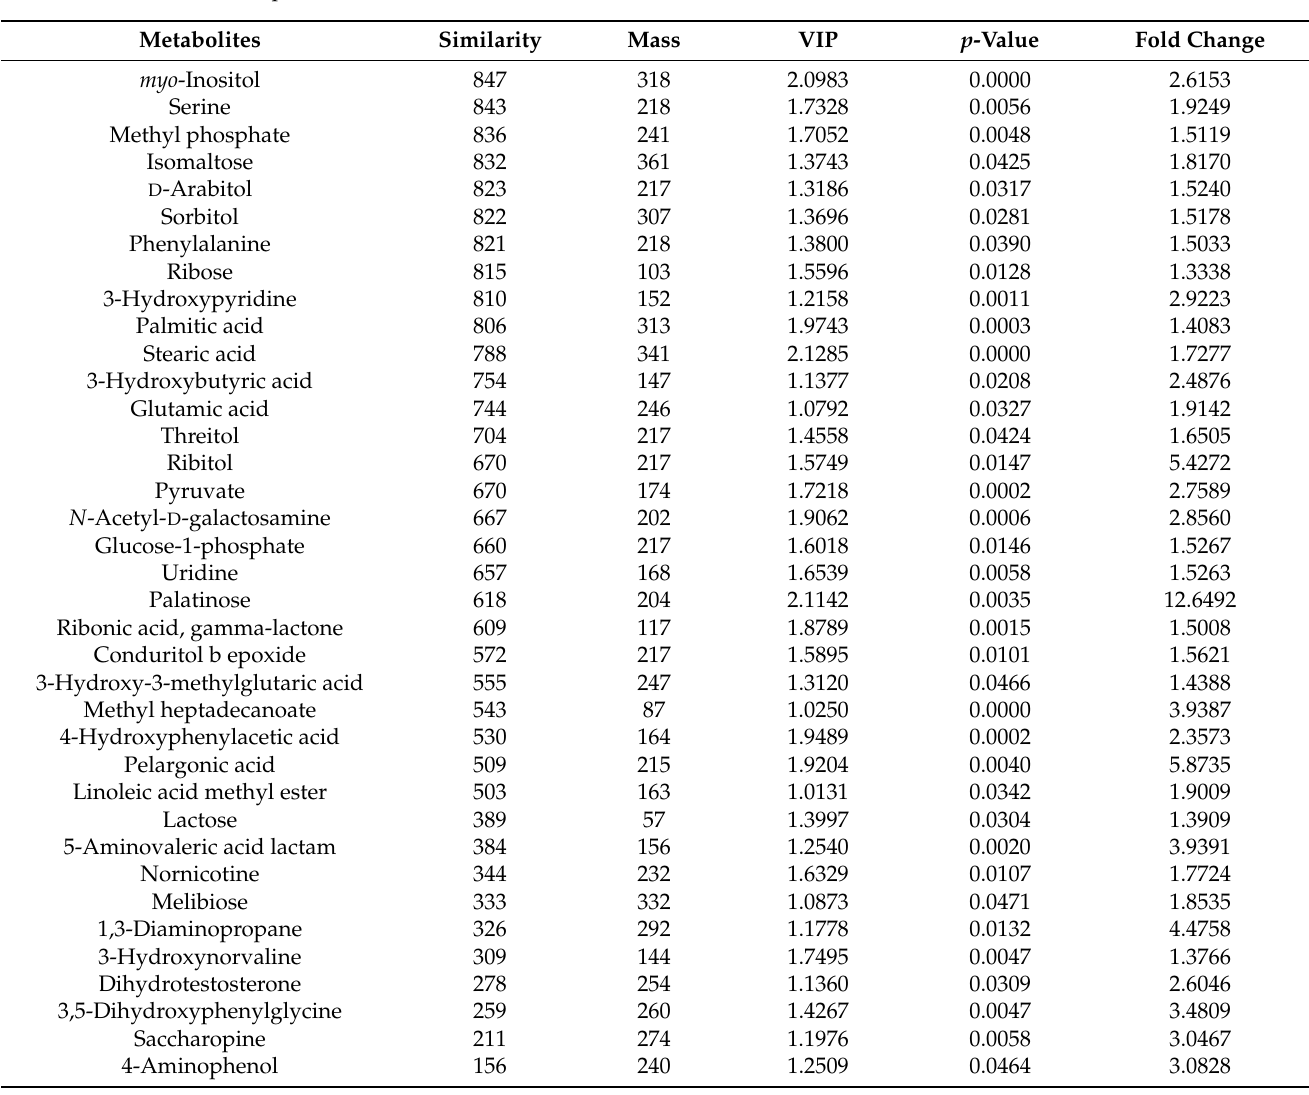
Table 1. Significantly differentially abundant metabolites that were increased in termites fed a M. micrantha leaves diet relative to those fed a pinewood diet.